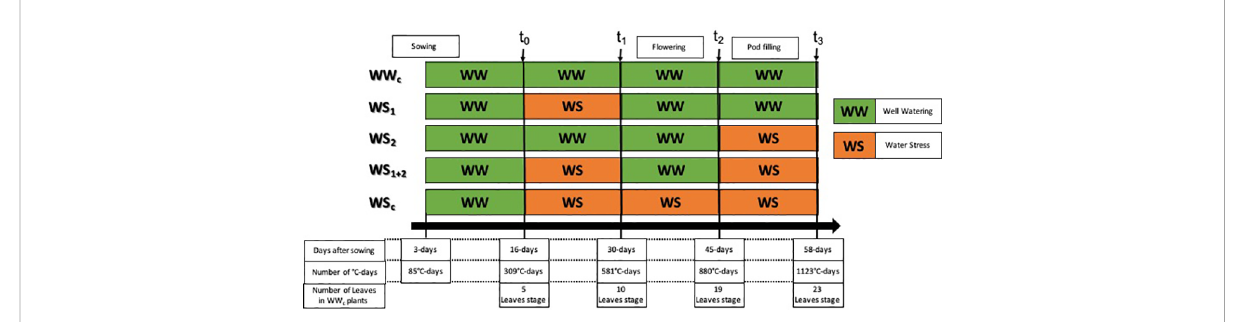
FIGURE 1 Experimental design used to characterize the response of pea plants to four types of water stress. WS 1, transient at vegetative stage; WS 2, transient at the reproductive stage; WS 1+2 , recurrent stage; WS c , continuous stress. The control treatment corresponds to WW c . Well-watered (WW) corresponds to a well-watered period and WS corresponds to a period of water de fi